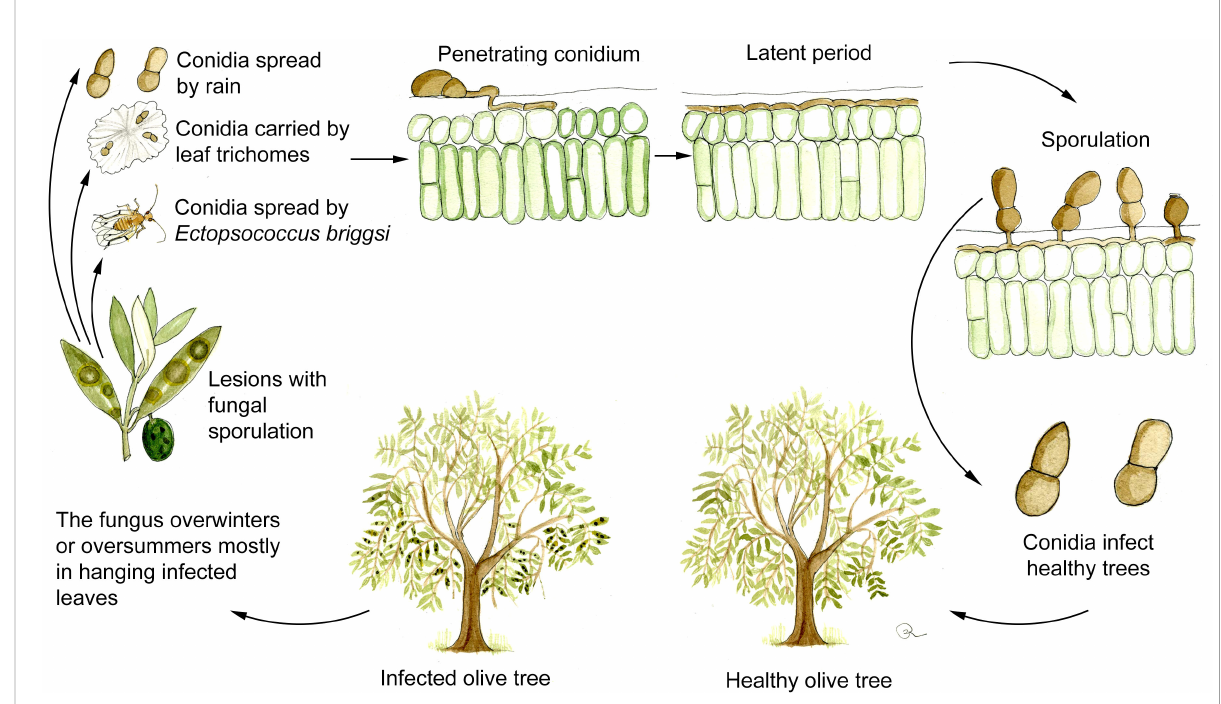
FIGURE 3 Disease cycle of olive leaf spot caused by Venturia oleaginea in olive trees. Figure drawn by Roberto